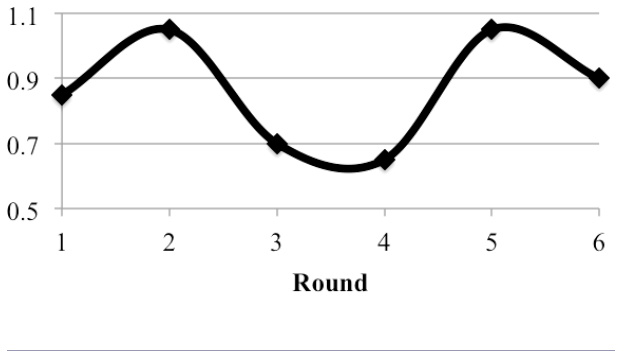
Fig. 6 . Round-wise delivery performance